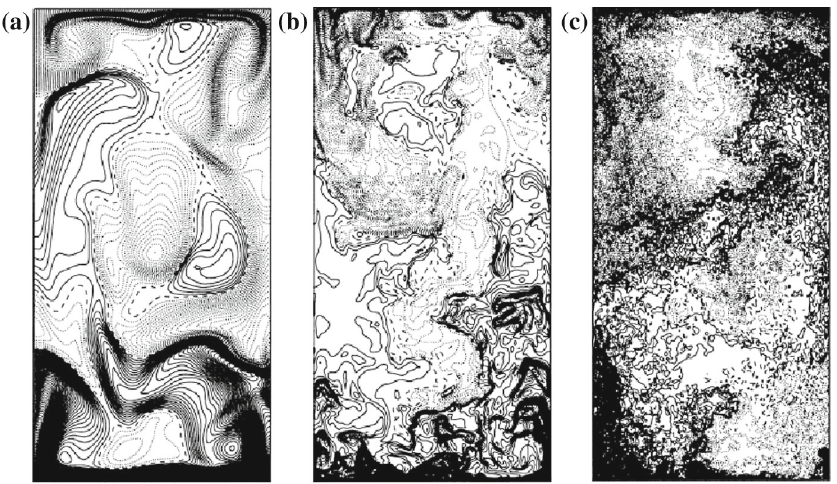
Fig. 9 Snapshots of temperature fluctuations in a vertical plane, from numerical simulations of Rayleigh– Bénard convection in a slender cylindrical cell at Pr = 0 . 7 and Rayleigh-numbers a 2 × 10 7 , b 2 × 10 9 , c 2 × 10 11 . Image reproduced with permission from Verzicco and Camussi (2003), copyright by